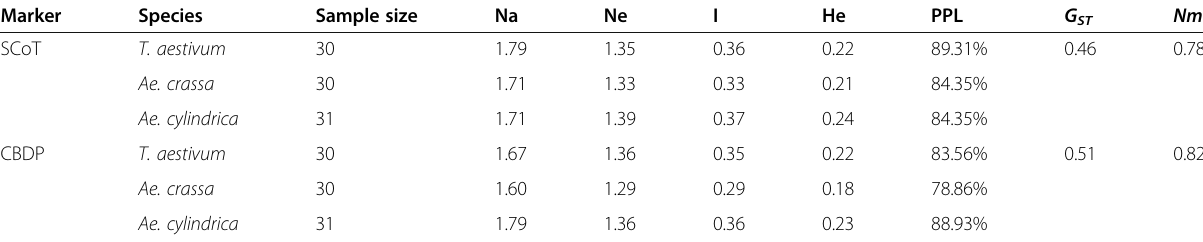
Table 3 Estimated genetic parameters in bread wheat and two Aegilops using SCoT and CBDP markers Marker Species Sample size Na